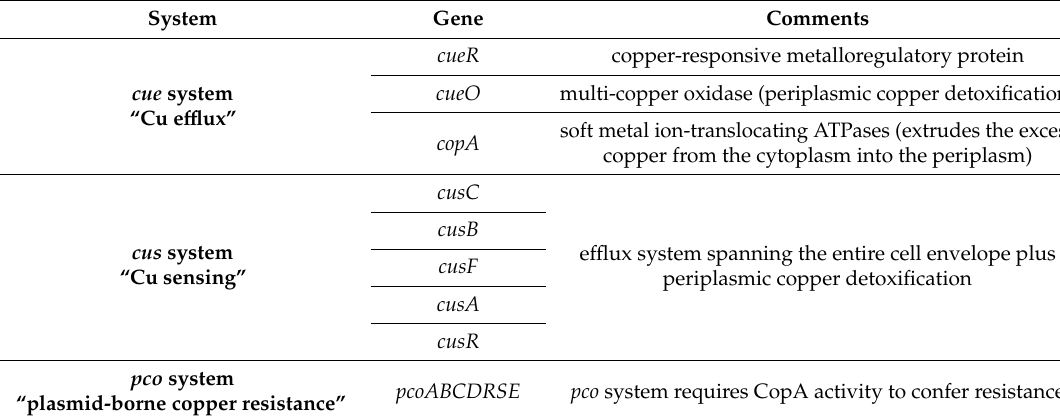
Table 1. Gram-negative copper homeostasis / resistance systems (Bondarczuk and Piotrowska-Seget, 2013) identified in E. coli